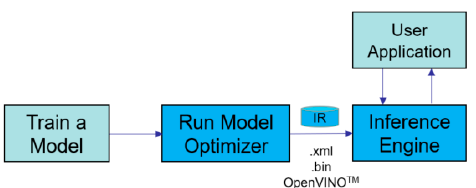
Figure 13. Step for utilizing OpenVINO to accelerate model.